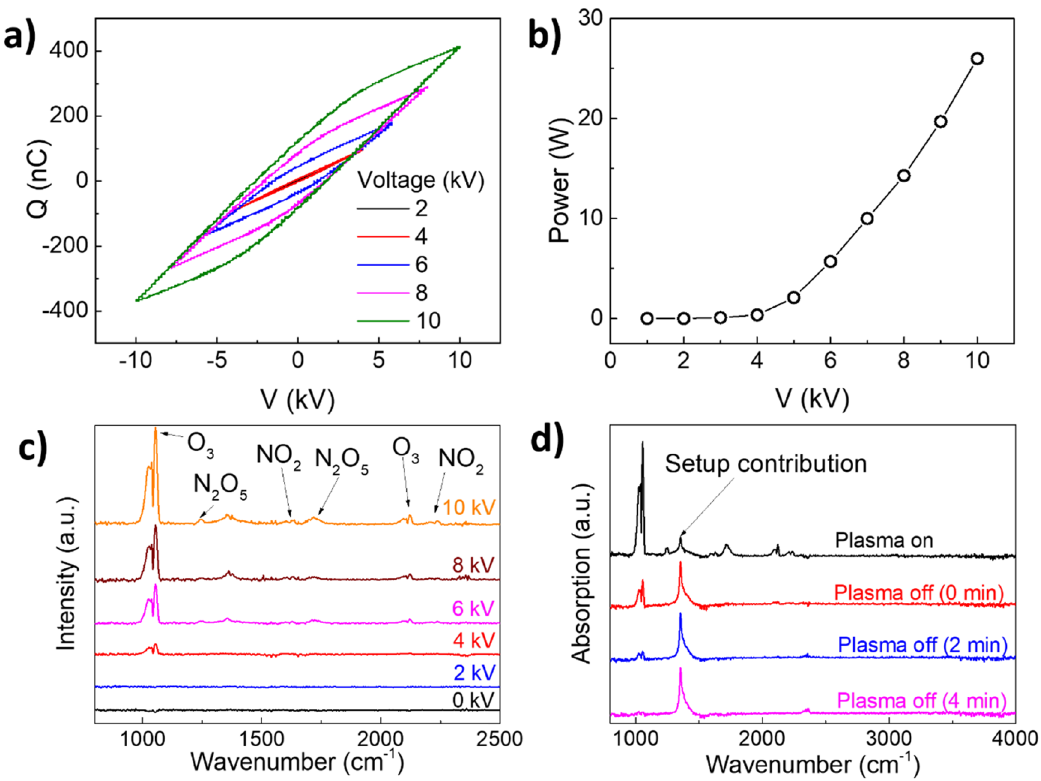
Figure 4. ( a ) Lissajous Figure as a function of applied voltage, ( b ) coupled power and ( c ) FTIR measured downstream of the reacator as a functon of applied voltage. ( d ) FTIR measurement dowstream of the plasma reactor in plasm-on condition, right after switching off the plasa, after 2 min and after 4